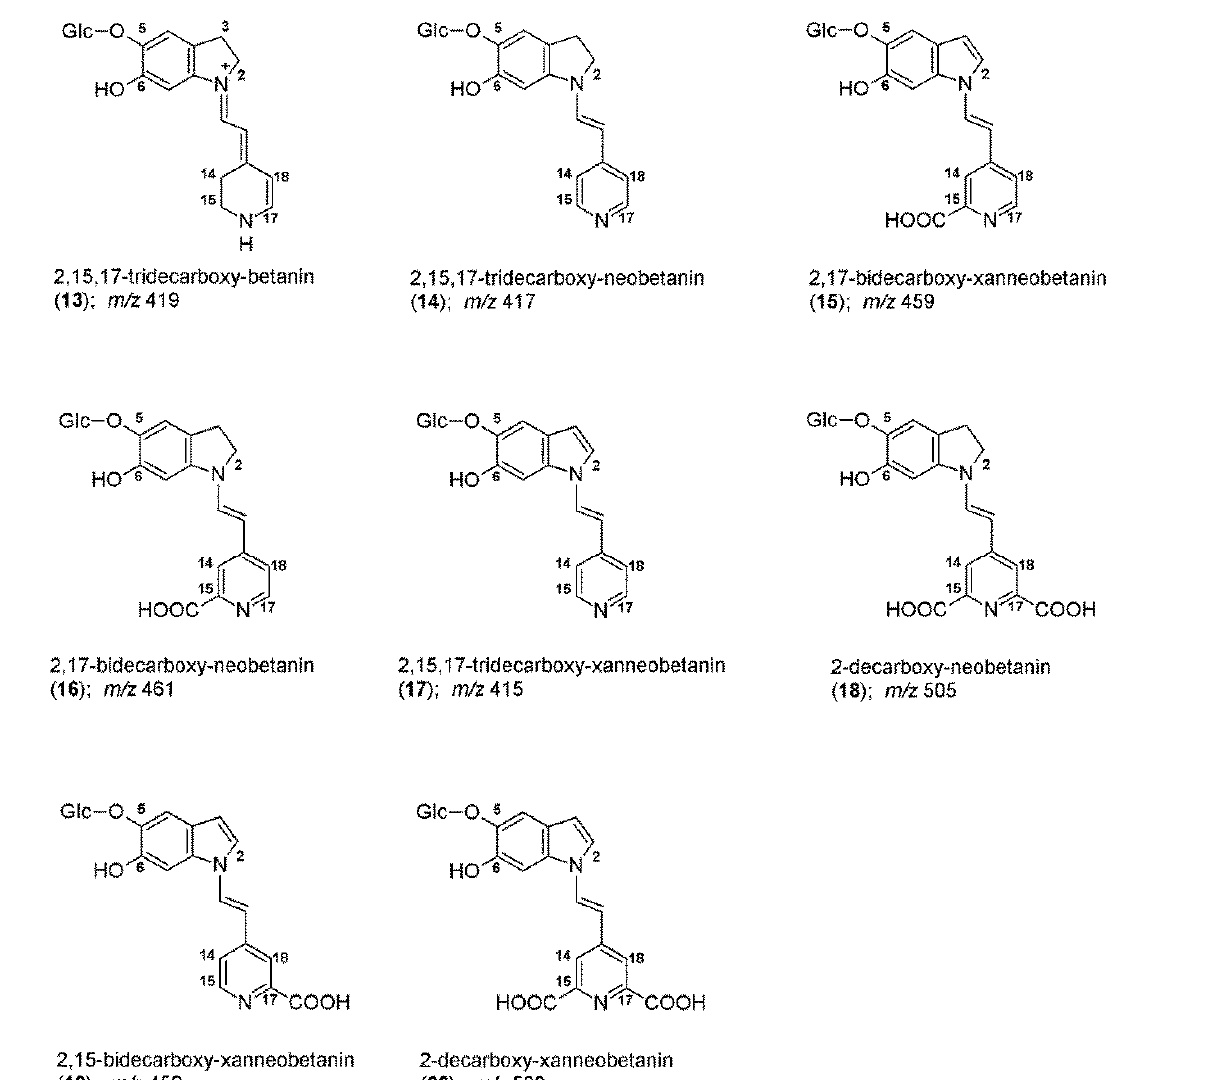
Figure 1. Chemical structures of betanin and its decarboxylated and dehydrogenated derivatives detected during the heating experiments of the betalain-rich extract/concentrate (BRE).